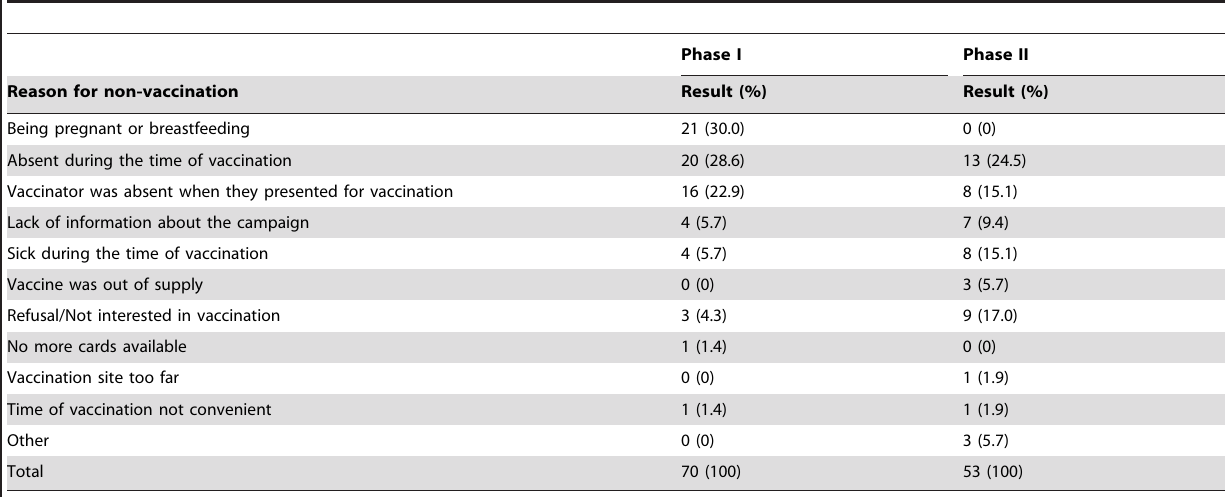
Table 2. Reasons for non-vaccination in the individuals reportedly not vaccinated during Phase I (n= 70) and Phase II (n= 53) of the MenAfriVac introduction campaign, Niamey and Tillabe´ri, Niger, September–December 2010.